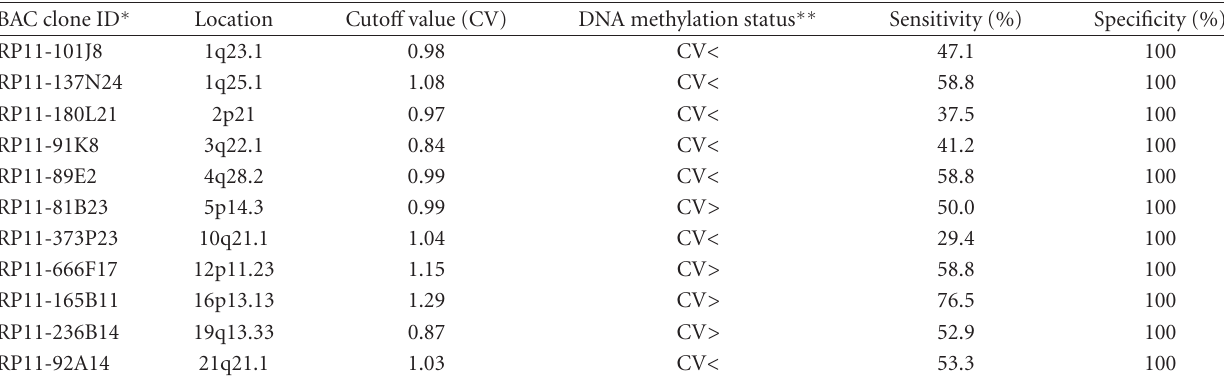
Table 3: Eleven BAC clones that were able to discriminate patients belonging to the early-relapse group from those belonging to the no- relapse group in the learning cohort with 100% specificity.